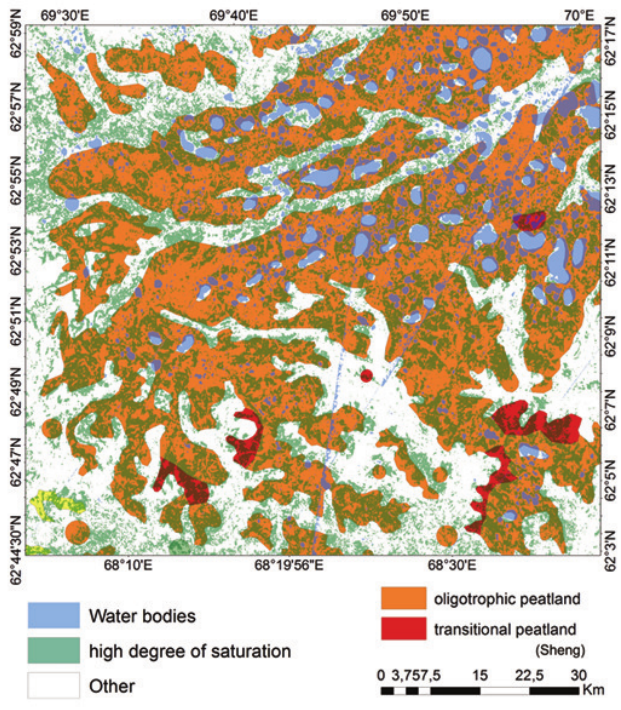
Figure 11. Classification of this study (water bodies: blue, saturated areas: green) over peatland classification [17] oligotrophic peatlands: orange. Universal Polar Stereographic projection, extent: S3 in Figure 3.